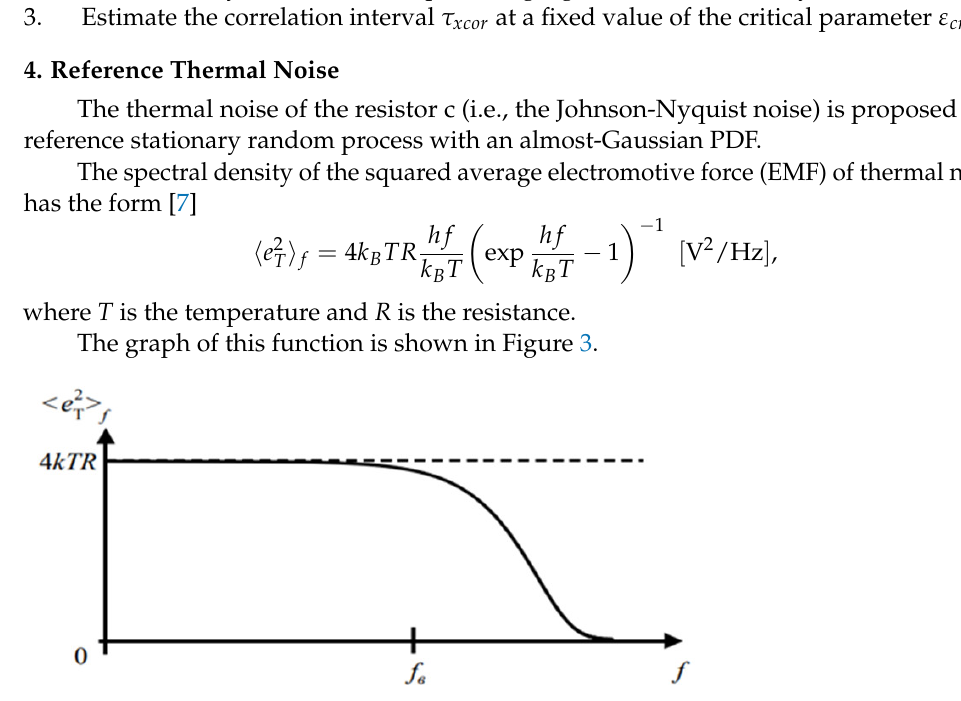
Figure 3. The spectral density of squared average EMF of the thermal noise.